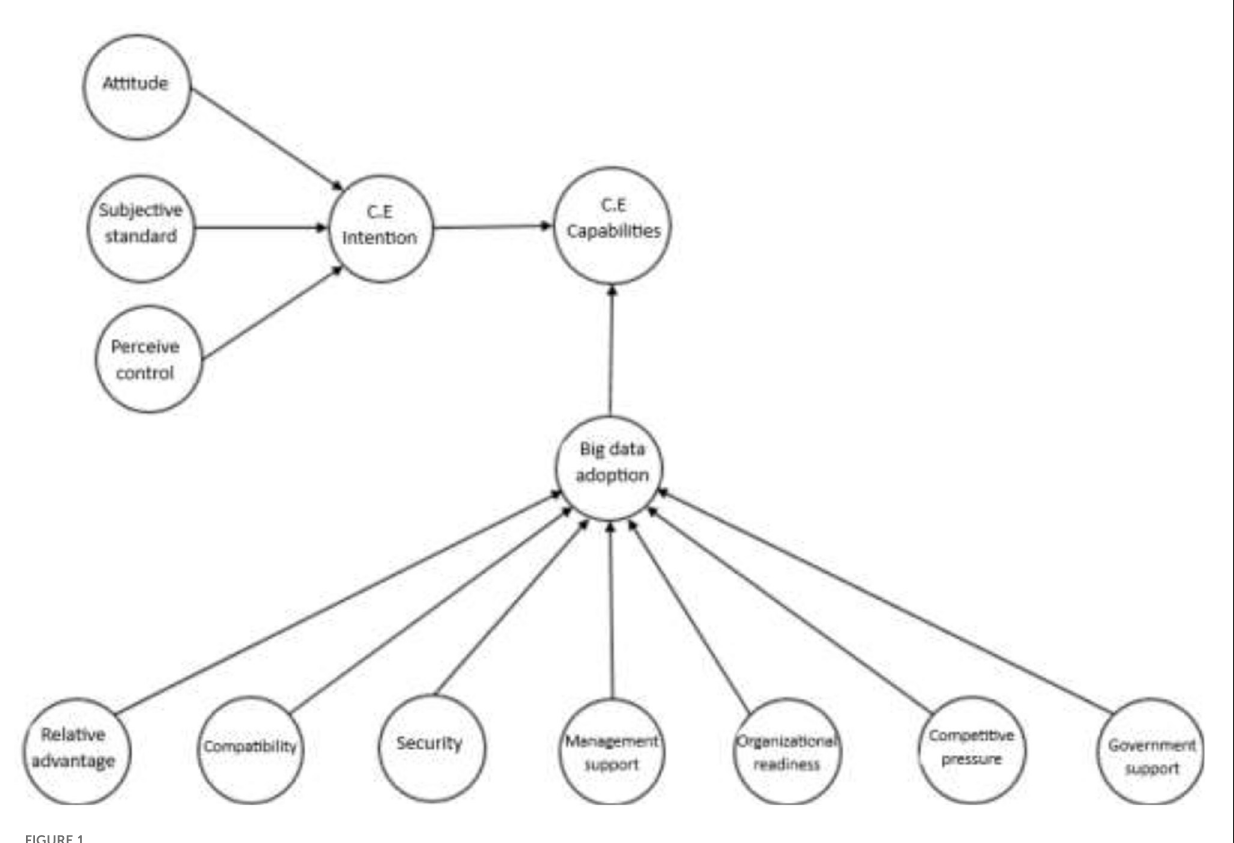
FIGURE1 Proposed research